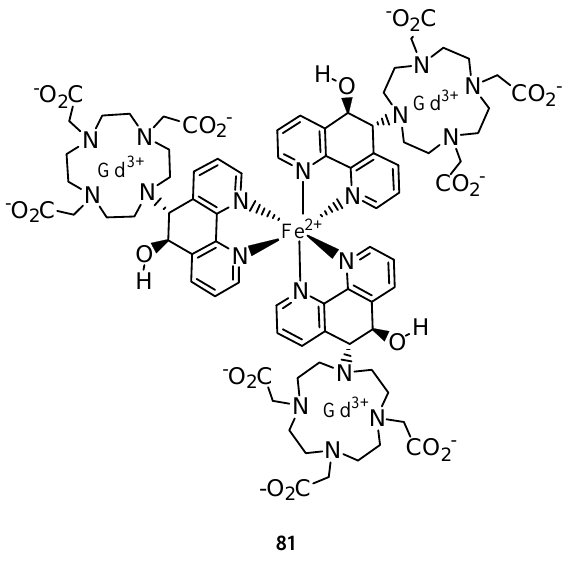
Figure 7 . Multinuclear complex based on